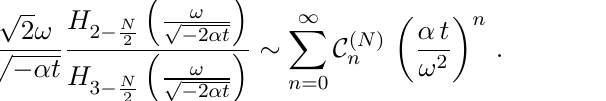
Figure 3 . The 17 zeroes on the complex plane z = x + iy for H 1 When applied to eq. (3.3) this leads to the expansion in eq.